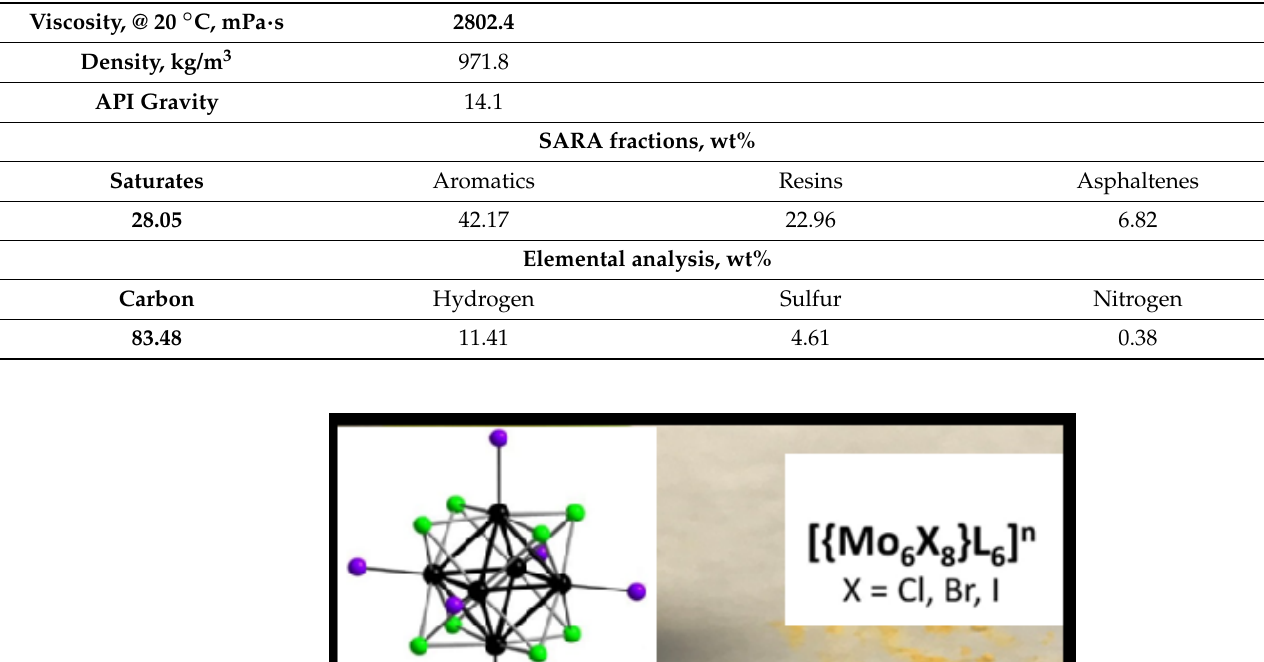
Table 1. Physical and chemical properties of initial heavy oil.